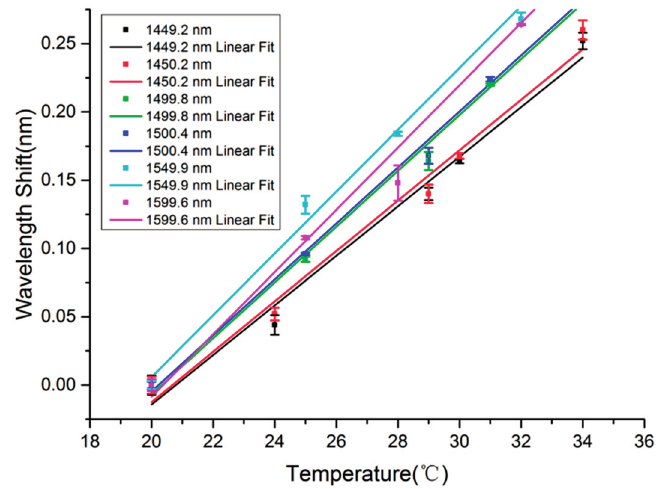
Figure 9. The linear fittings of resonant wavelength with temperature for MKR with 3.91- μ m-diameter microfiber under probing wavelengths of 1449.2, 1450.2, 1499.8, 1500.1, 1549.9 and 1599.6 nm. The error bars show the differences between experimental and fitting results.